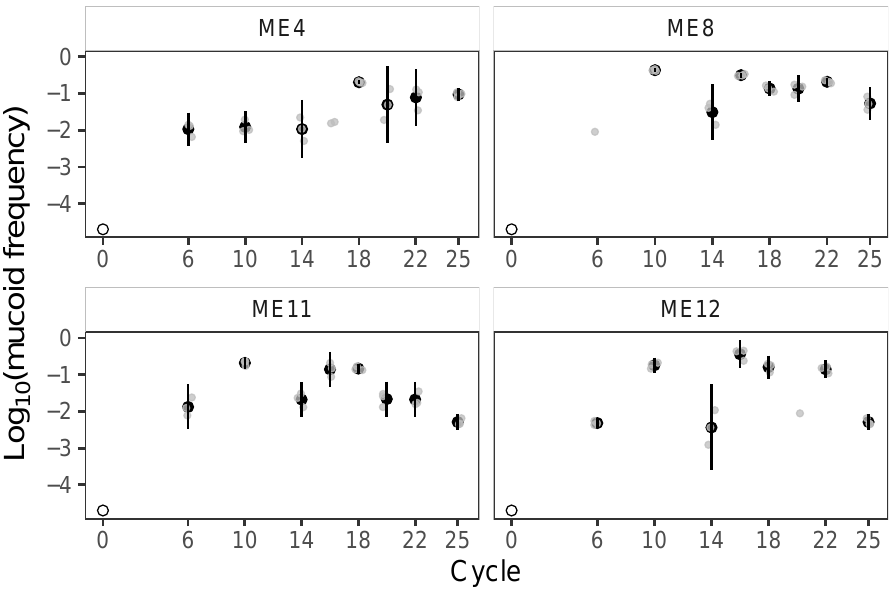
Figure 1. Mucoid prey rose to and persisted within intermediate frequency ranges in MyxoEE-6 in four focal populations. Frequencies of mucoid variants among the four focal coevolving prey populations estimated hypothetically at the start of MyxoEE-6 (cycle 0, open circles) and estimated directly by sampling at the end of eight MyxoEE-6 cycles (see Methods). A mucoid frequency of ∼ 10 − 5 at cycle 0 is shown for a hypothetical scenario in which there was one mucoid cell among the ∼ 10 5 starting prey cells for each E. coli population. Grey dots show individual replicate estimates, black dots indicate cross-replicate means and error bars show 95% confidence intervals ( t -distribution, three temporally separated biological